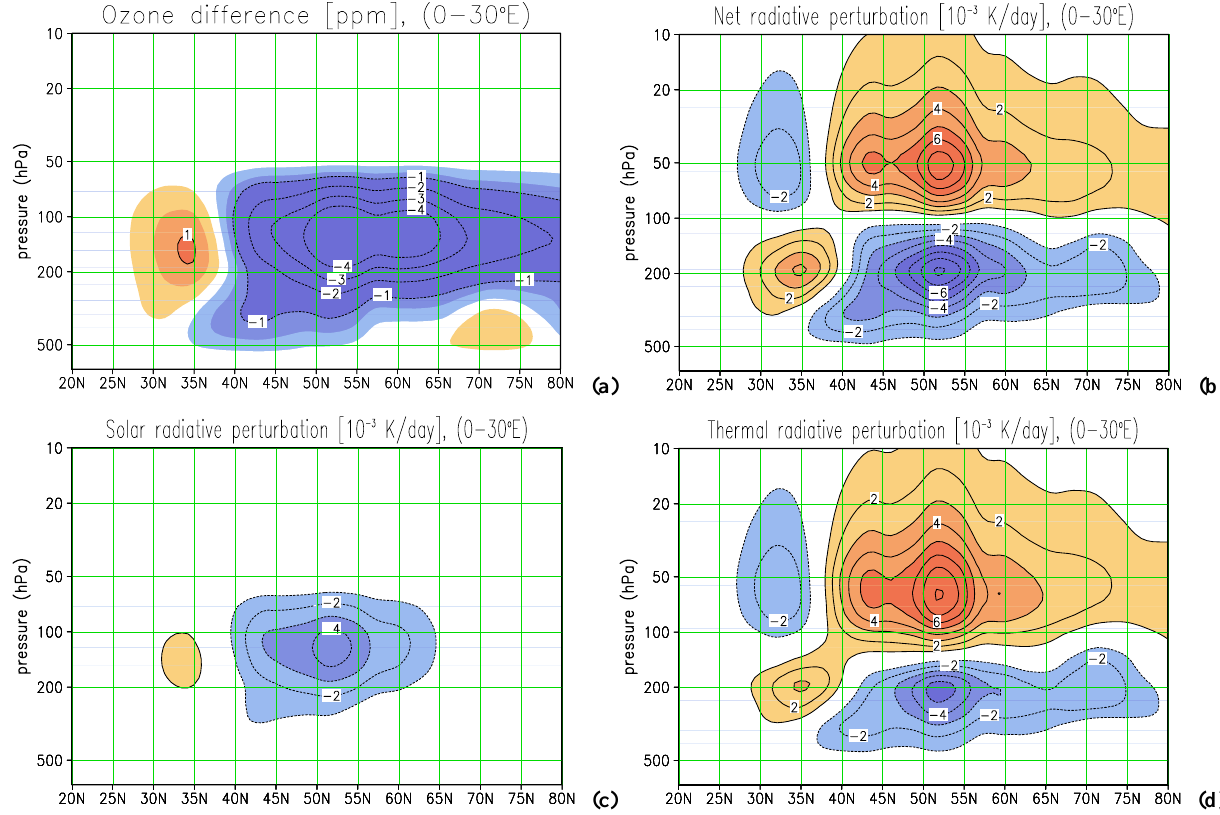
Fig. 3. Ozone anomaly and radiation forcing zonally averaged (0–30 ◦ E). Same as in Fig. 2, but zonally averaged (0–30 ◦